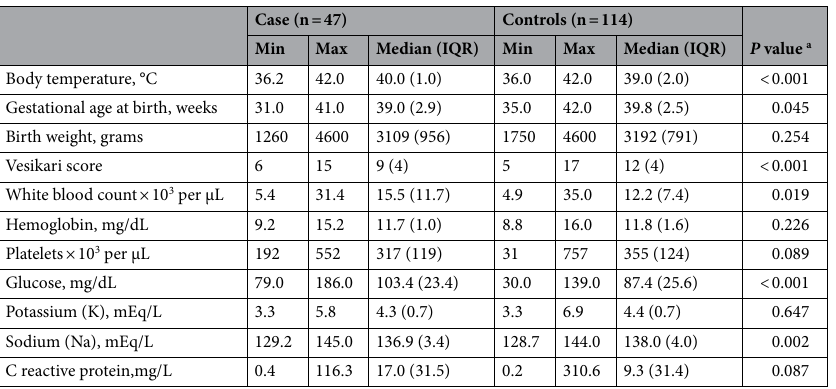
Table 3. Clinical characteristics of children hospitalized for acute gastroenteritis with convulsions (cases) and without convulsions (controls). a P value was obtained by the Mann–Whitney U test given skewed distributions for most variables in the table. IQR interquartile range, Min minimum value, Max maximum value.